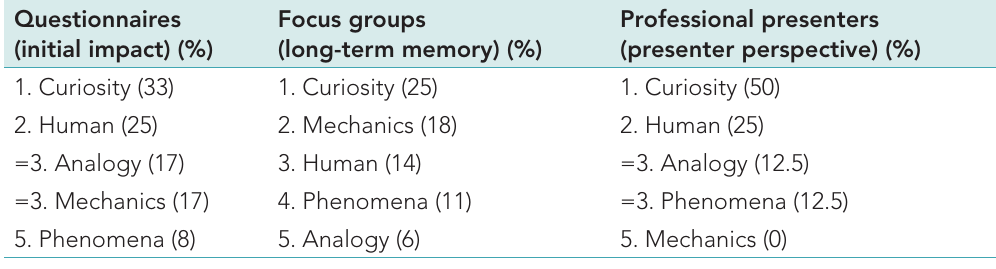
Table 6: Triangulation of data showing the prioritizing of demonstration categories from the different elements of the research